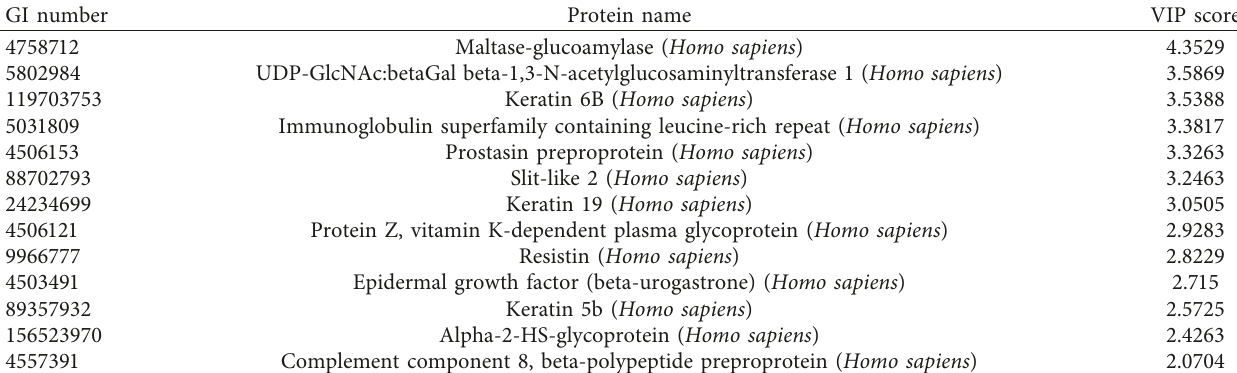
Table 2: Top discriminating proteins for AKI with false discovery rate < 10%.